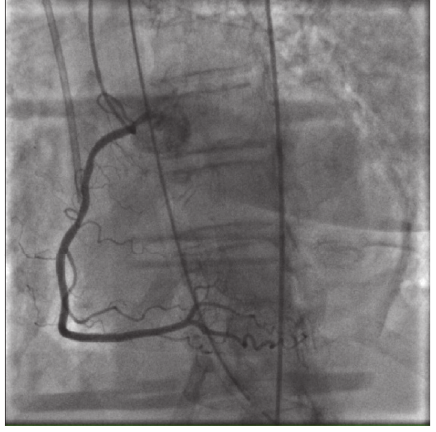
Figure 3: Right coronary artery.